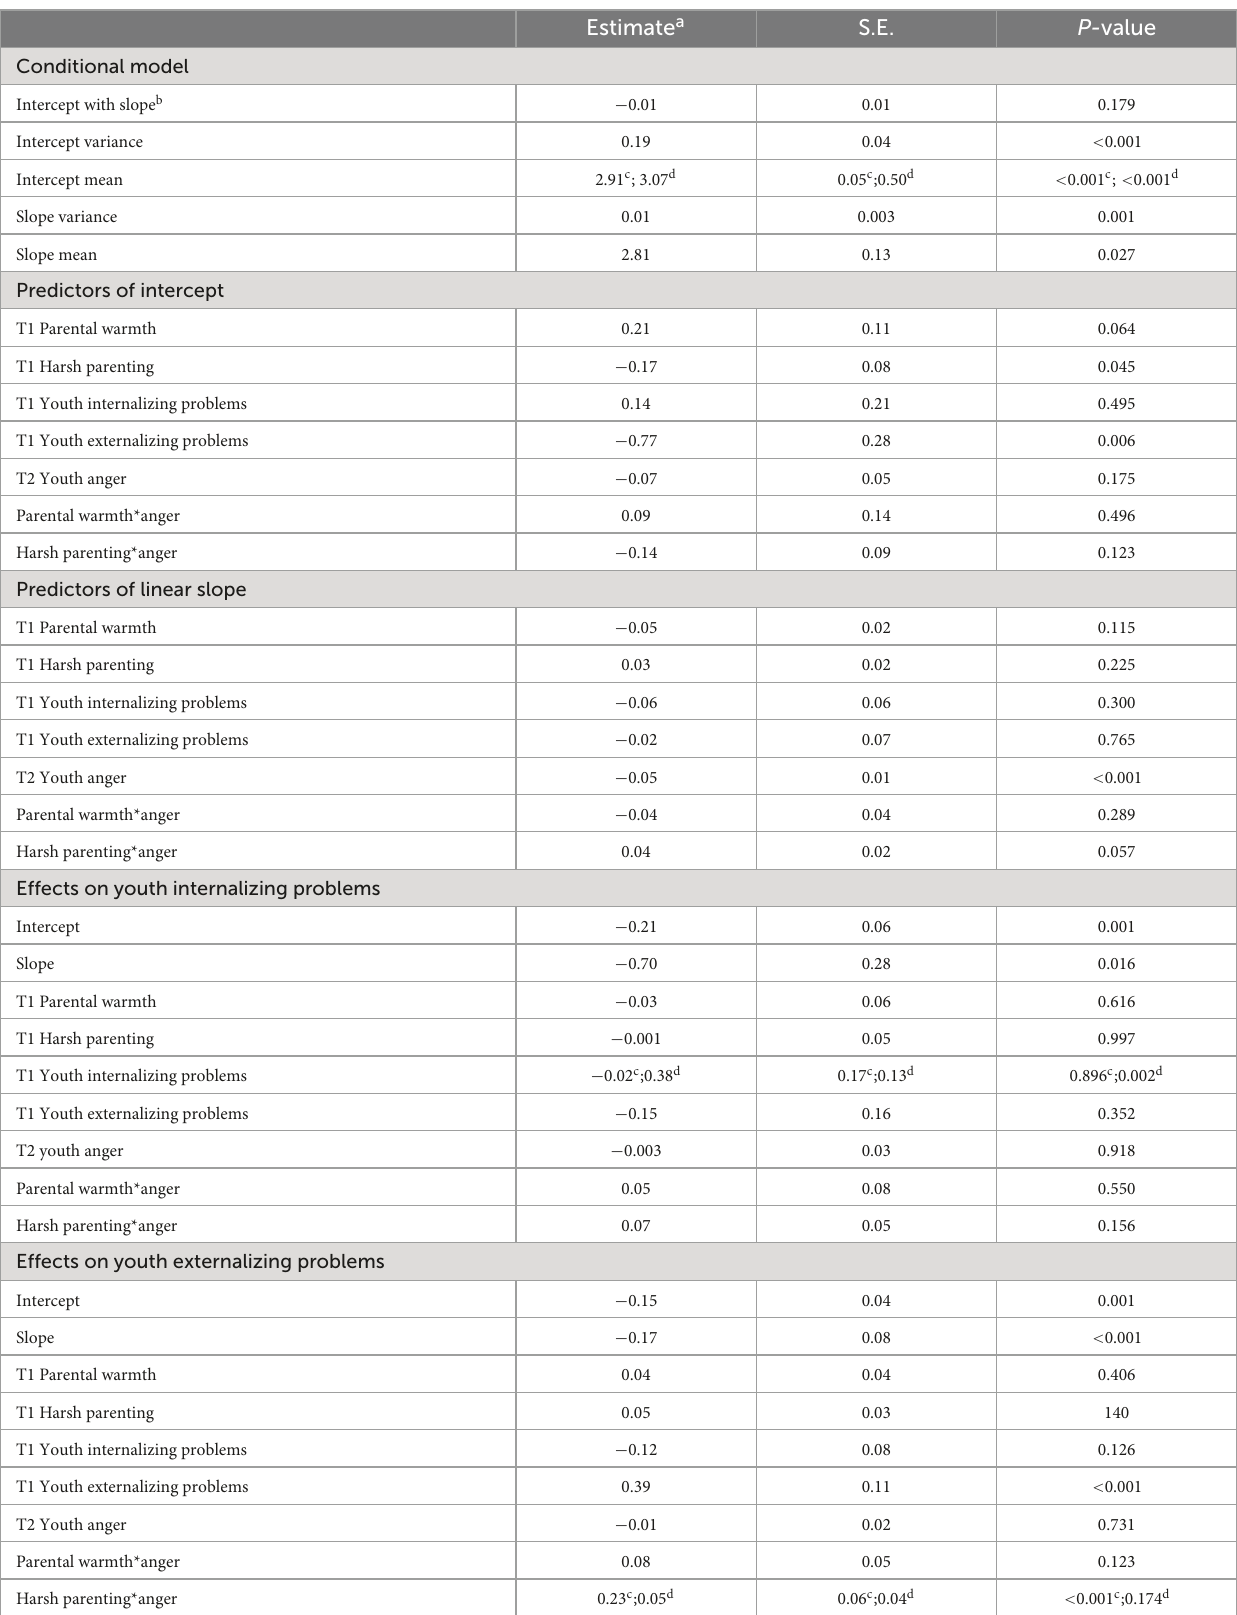
TABLE 1 Unconditional and conditional multi-group latent growth curve models 1 for self-efficacy about anger